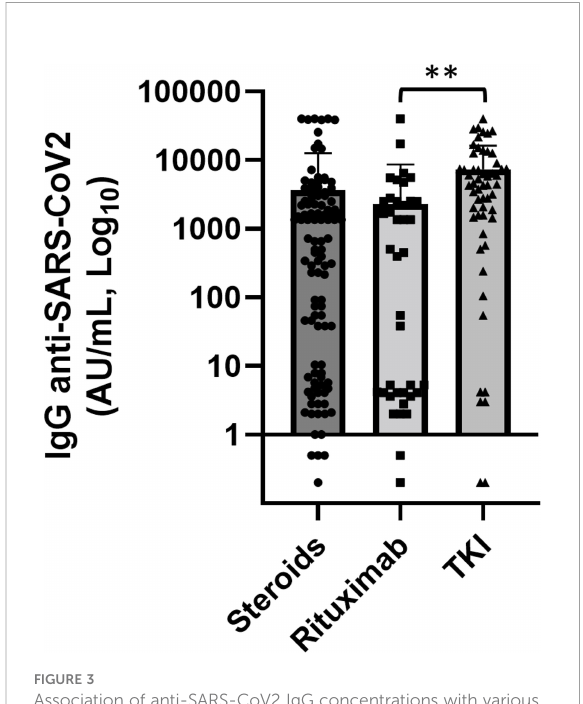
FIGURE 3 Association of anti-SARS-CoV2 IgG concentrations with various anticancer treatments. Patients treated with rituximab (n = 30) showed signi fi cantly lower levels of anti-SARS-CoV-2 IgG than patients treated with tyrosine kinase inhibitors (TKI) (n = 44) (p = 0.004). Differences assessed by one-way ANOVA test (p = 0.005), Bonferroni post-hoc test: (**) p < 0.005. Error bars correspond to standard deviation calculated from the mean of relative concentrations. Values below the black line correspond to anti-SARS-CoV-2 IgG lower than 10.0 AU/ml, and values of 0 AU/ml were not shown since the graph is on a log